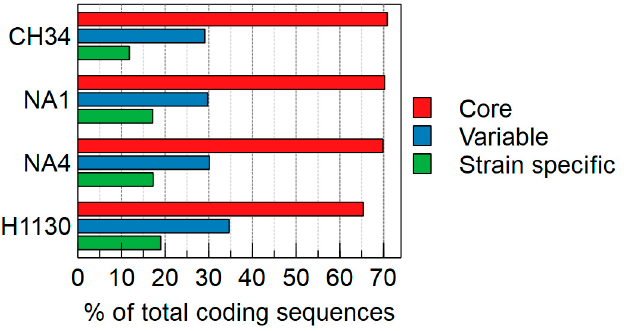
Figure 2. Percentage of coding sequences (CDSs) belonging to the core, variable (shared by two or three strains) and strain-specific genome of Cupriavidus metallidurans CH34, NA1, NA4 and H1130.